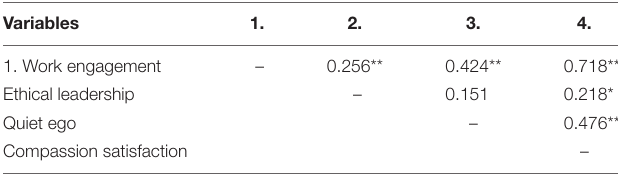
TABLE 1 | Correlations among work engagement, ethical leadership, quiet ego, and compassion satisfaction.